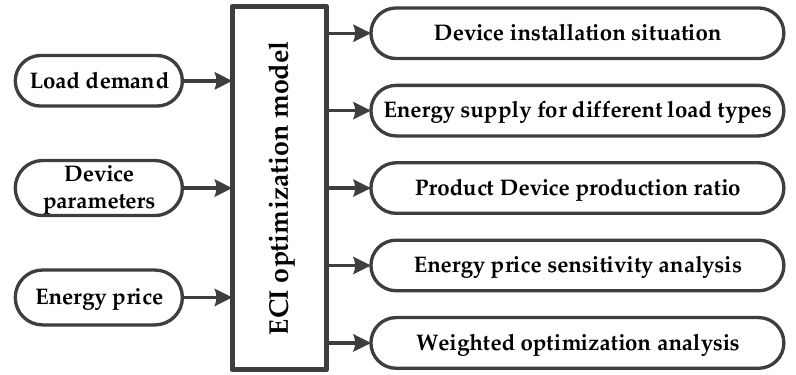
Figure 6. Optimal energy-conversion-interface configuration system.